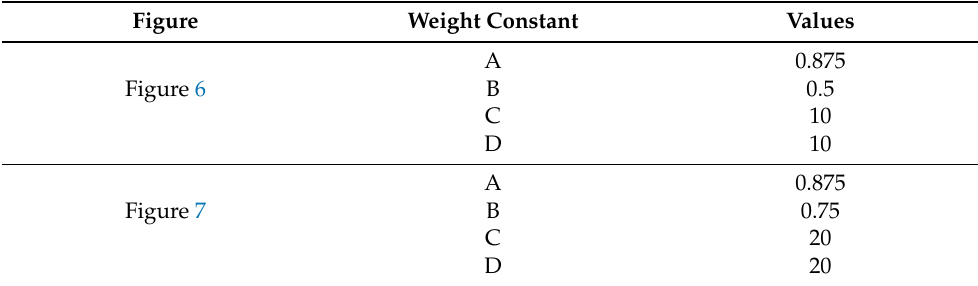
Table 3. The numerical values of the weight constants and initial sizes of the compartmental